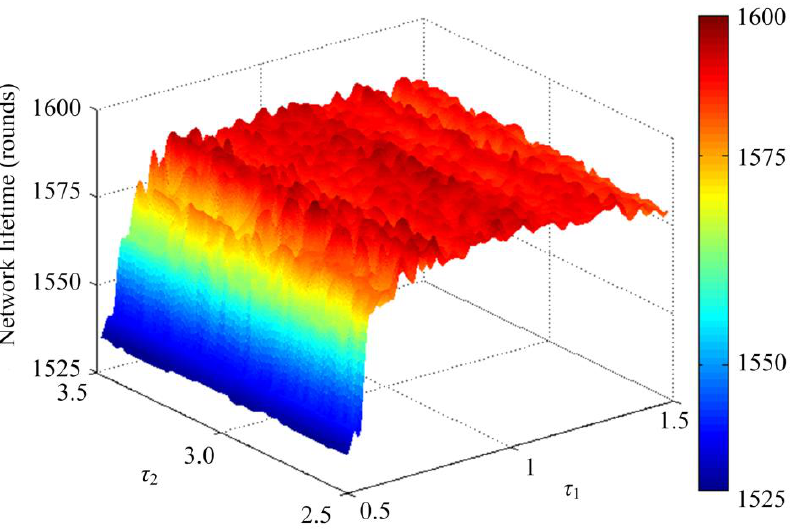
Figure 4. Plot of network lifetime with 100% sensing coverage versus τ λ = 0.7 and λ 1